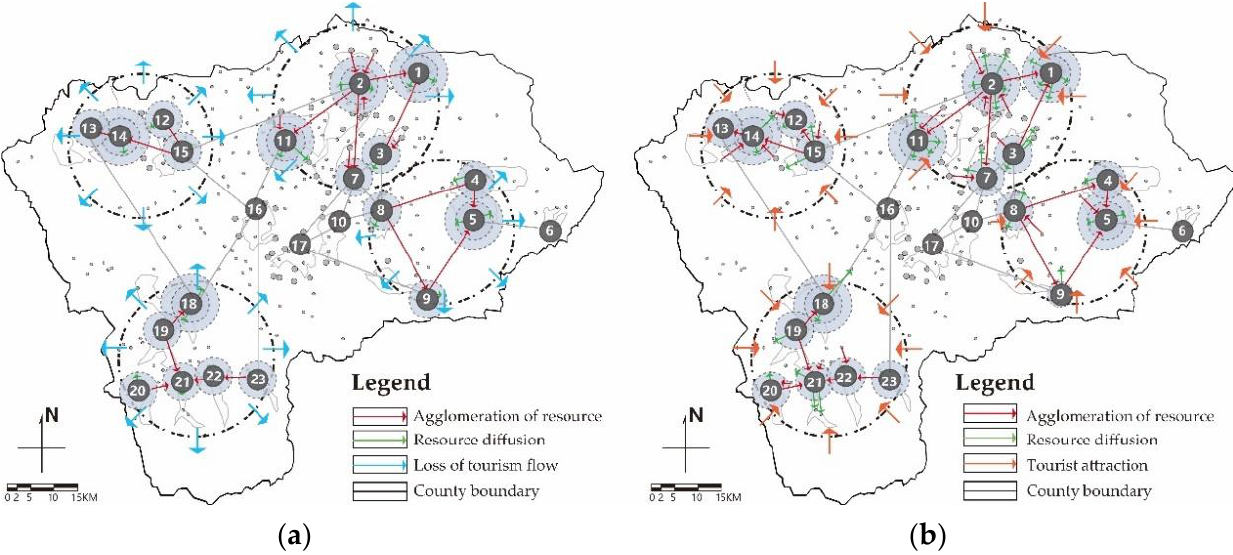
Figure 13. Transformation of the network structure and organization mode: ( a ) overall dispersion with a partial concentration and ( b ) overall concentration with a partial dispersion.